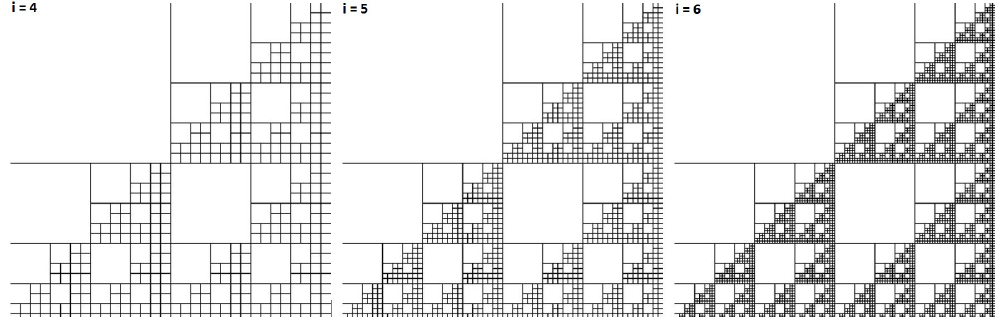
Figure 3. Deterministic fractal-fracture networks with iterations, i = 4, 5 and 6.